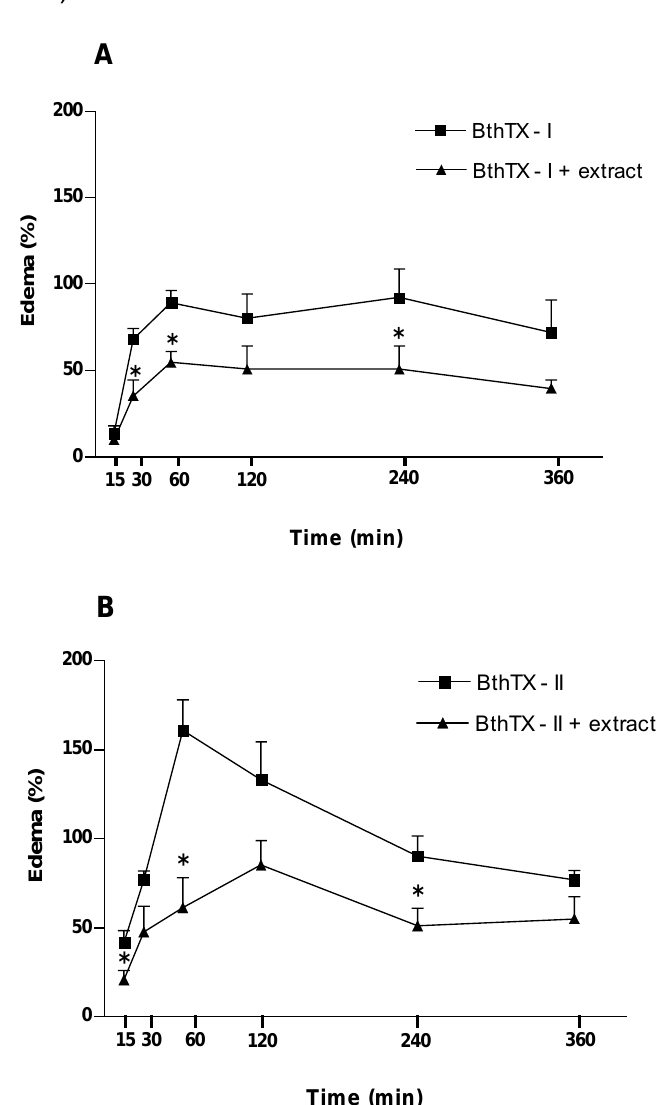
Figure 2. Effects of ethanolic extract from the B. portulacoides aerial parts on edema formation induced by BthTX-I and BthTX-II. ( A ) BthTX-I and ( B ) BthTX-II. Mice were pretreated with the B. portulacoides ethanolic extract (500 mg/kg, i.p.) one